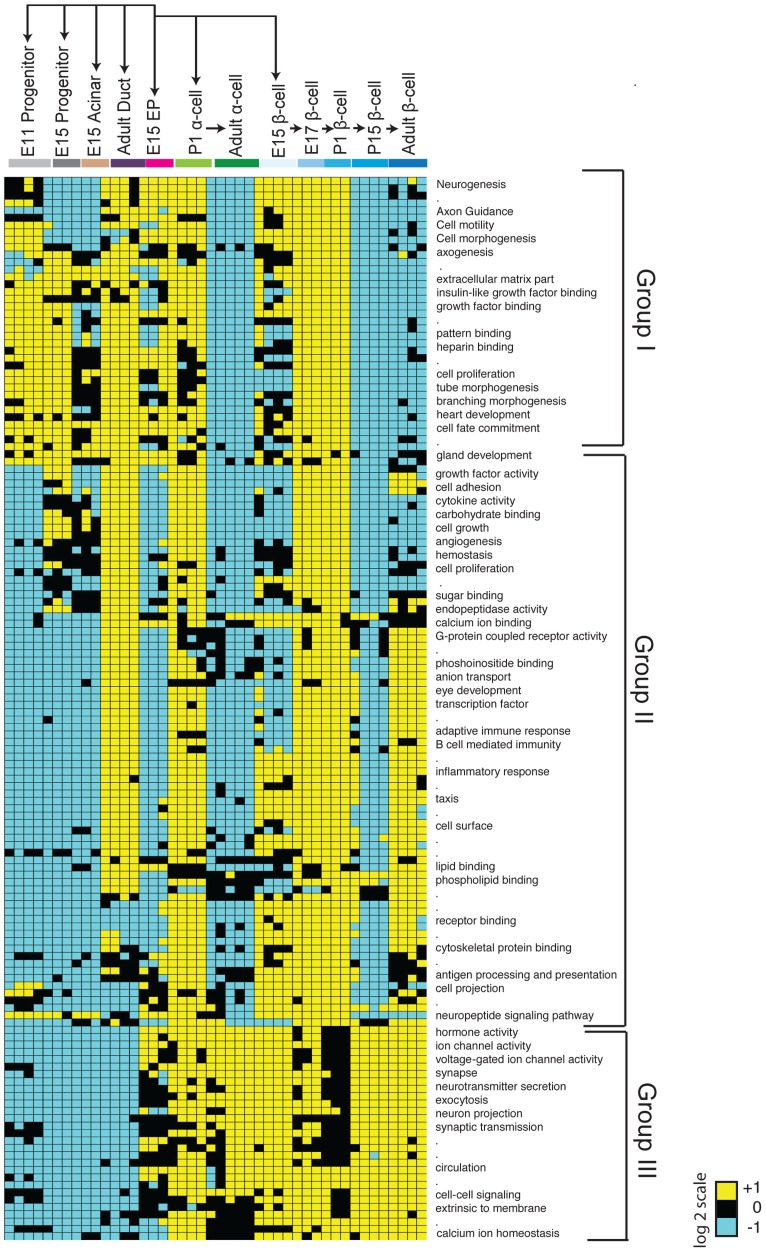
Module map analysis of differentially expressed gene sets.The module map algorithm of Genomica software was executed to identify gene-sets (representing gene ontology biological functions) that are differentially expressed between 12 cell populations representing various stages and cell types of the pancreas. Each individual block represents the average expression of statistically enriched (yellow) or depleted (teal) genes based on a log2 scale (P<0.05 and FDR<0.05, Cut-off values >1 or <−1, based on a log2 scale). Black blocks indicate that there was no significant enrichment or depletion of a gene-set. Because of resolution and space constraints not all gene set terms are displayed (signified with dots). Endocrine progenitor (EP).